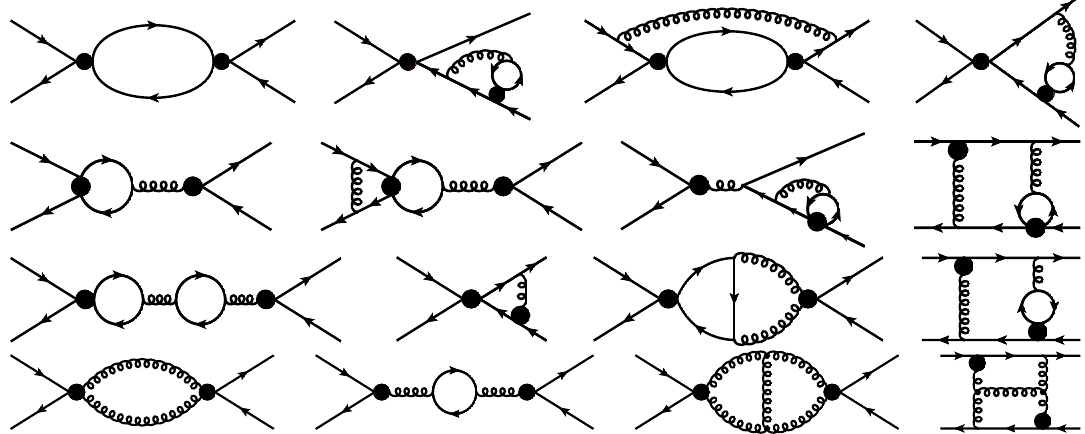
Figure 1. Sample Feynman diagrams contributing to eq. (2.2) to the orders considered in this paper. From top to bottom they contribute to the Q pieces of H ∆ B =1 ( x ) H ∆ B =1 (0) in eq. (2.2), with the blobs denoting the corresponding current-current eff eff or penguin